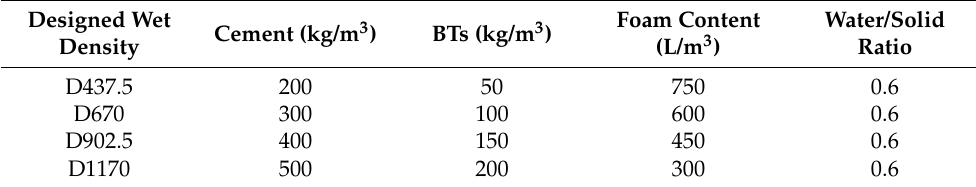
Table 3. Chemical composition and mineral composition of